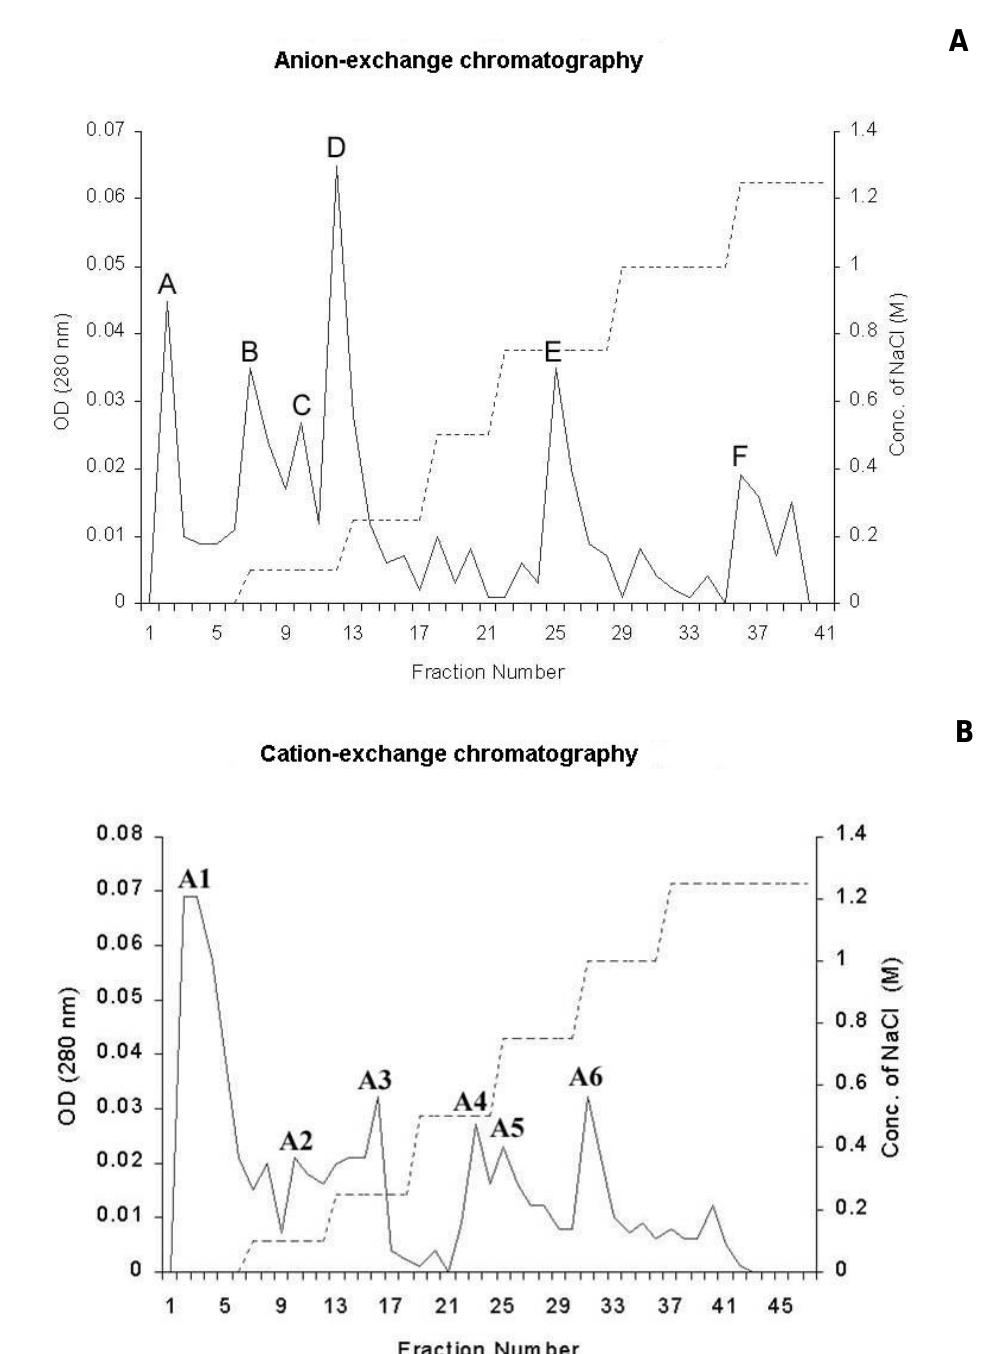
Figure 5. Purification of the hemolytic toxin by ion-exchange chromatography. ( A ) Heteractis magnifica crude protein, dissolved in 10 mM sodium phosphate buffer (pH 7.0), was fractionated by DEAE-cellulose anion-exchange chromatography and fractions under peak A, showed hemolytic activity. ( B ) Peak A fractions obtained by anion-exchange chromatography were pooled and fractionated by CM-cellulose cation-exchange chromatography. After removal of the unbound components, a linear salt gradient (0-1.25 M NaCl in sodium phosphate buffer, indicated by the dashed line) was added. Fractions from peak A6 showed hemolytic